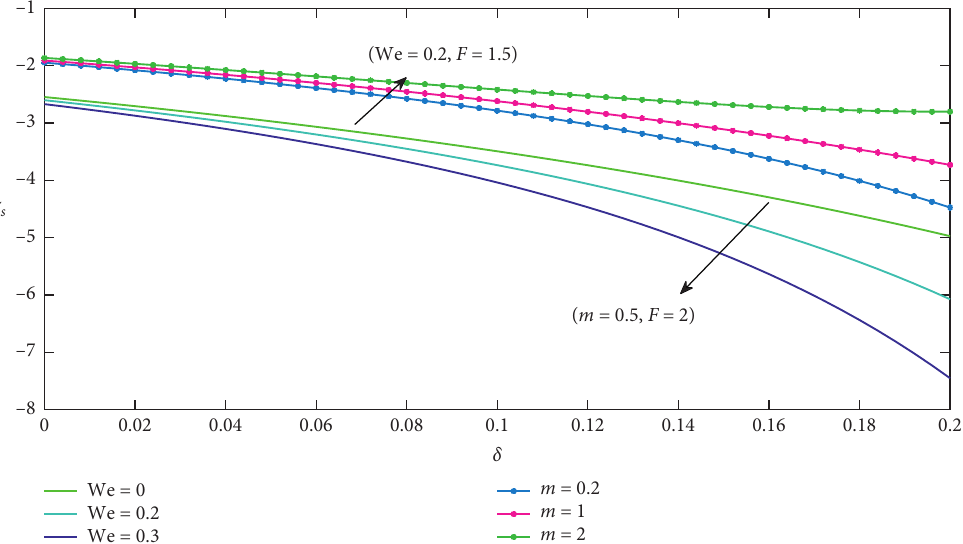
Figure 8: Variation of shear stress at the stenotic